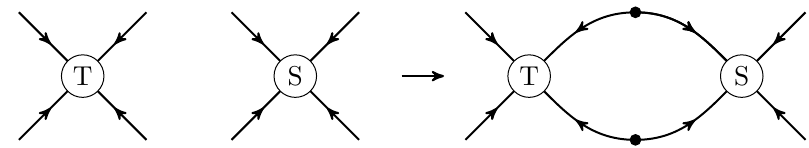
Figure 2. A basic example of a contraction of two quantum states into a tensor network. Alge- braically, the objects at left are written T abcd and S efgh . The object at right is T abcd δ ce δ df S efgh . quantum state, and the lines each correspond to a ket or bra index. For